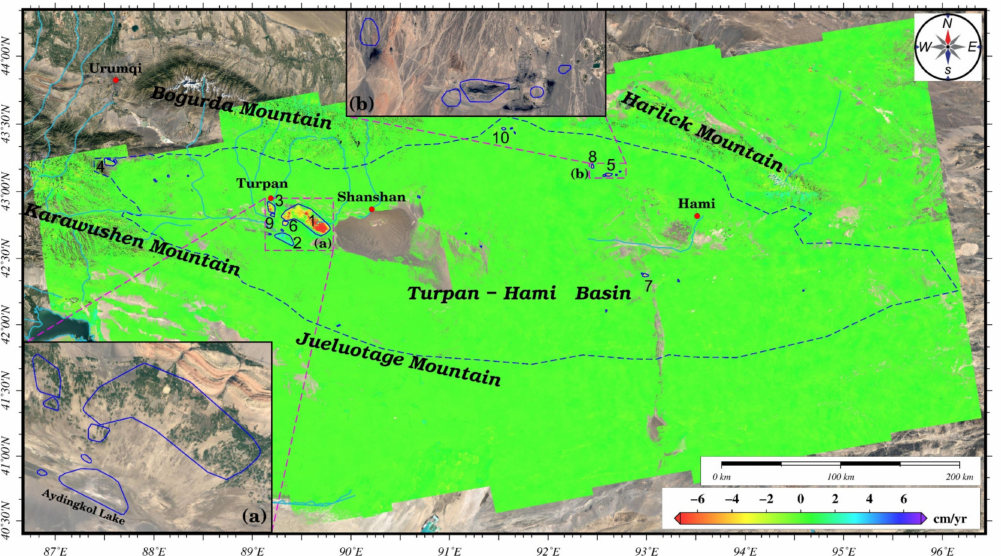
Figure 3. Wide-area subsidence rate map and the detected deformation regions. The numbers identify the location of the top 10 deformation regions. ( a ) The SFM–def region in Figure 4. ( b ) One of the major mining areas. Background image: Google Maps satellite image.